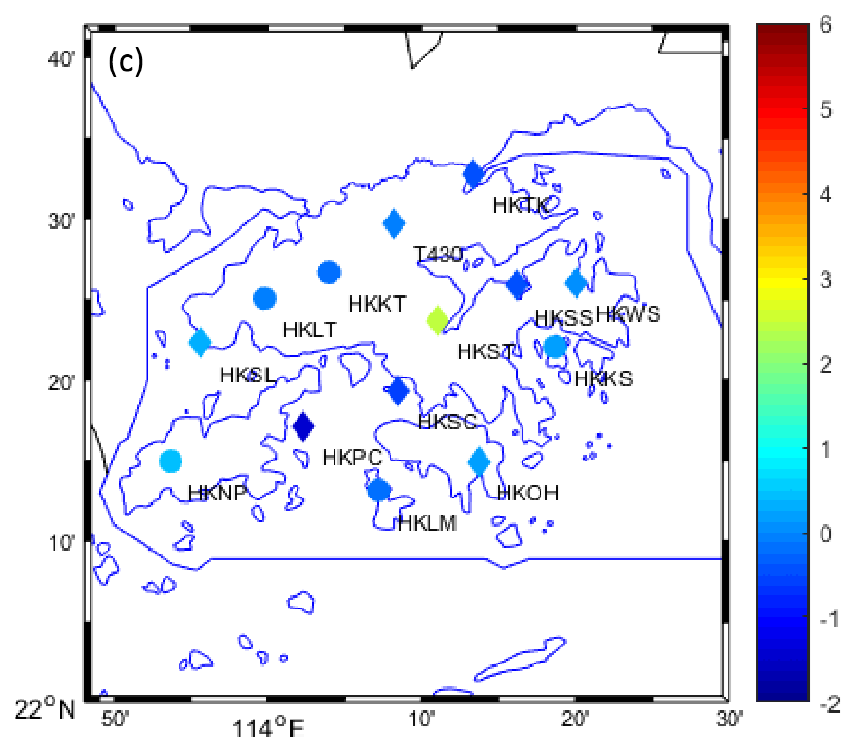
Figure 8. ( a – c ) Di ff erences (cm) between ZTDs provided by the fusion model and GNSS processing on the day 202 / 203 / 204 UTC 12:00.